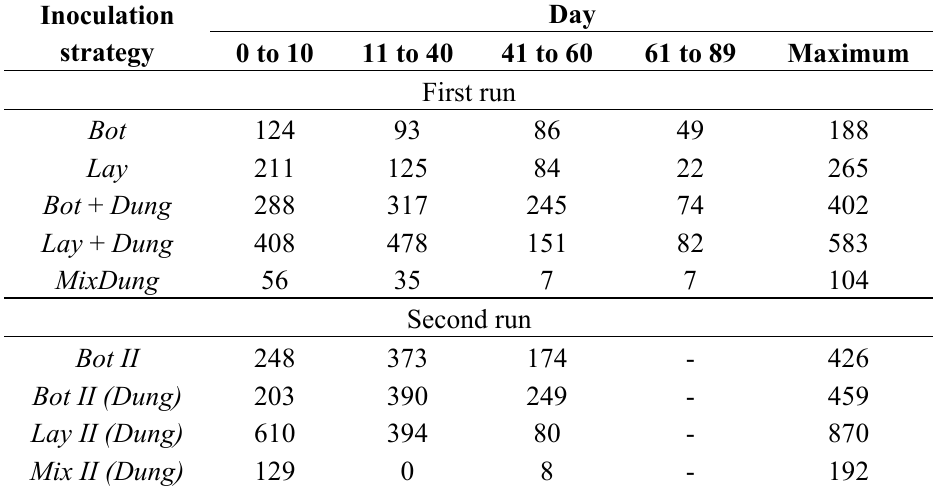
Table 4. Average and maximum methane production rates a in different phases during the SSAD experiments in